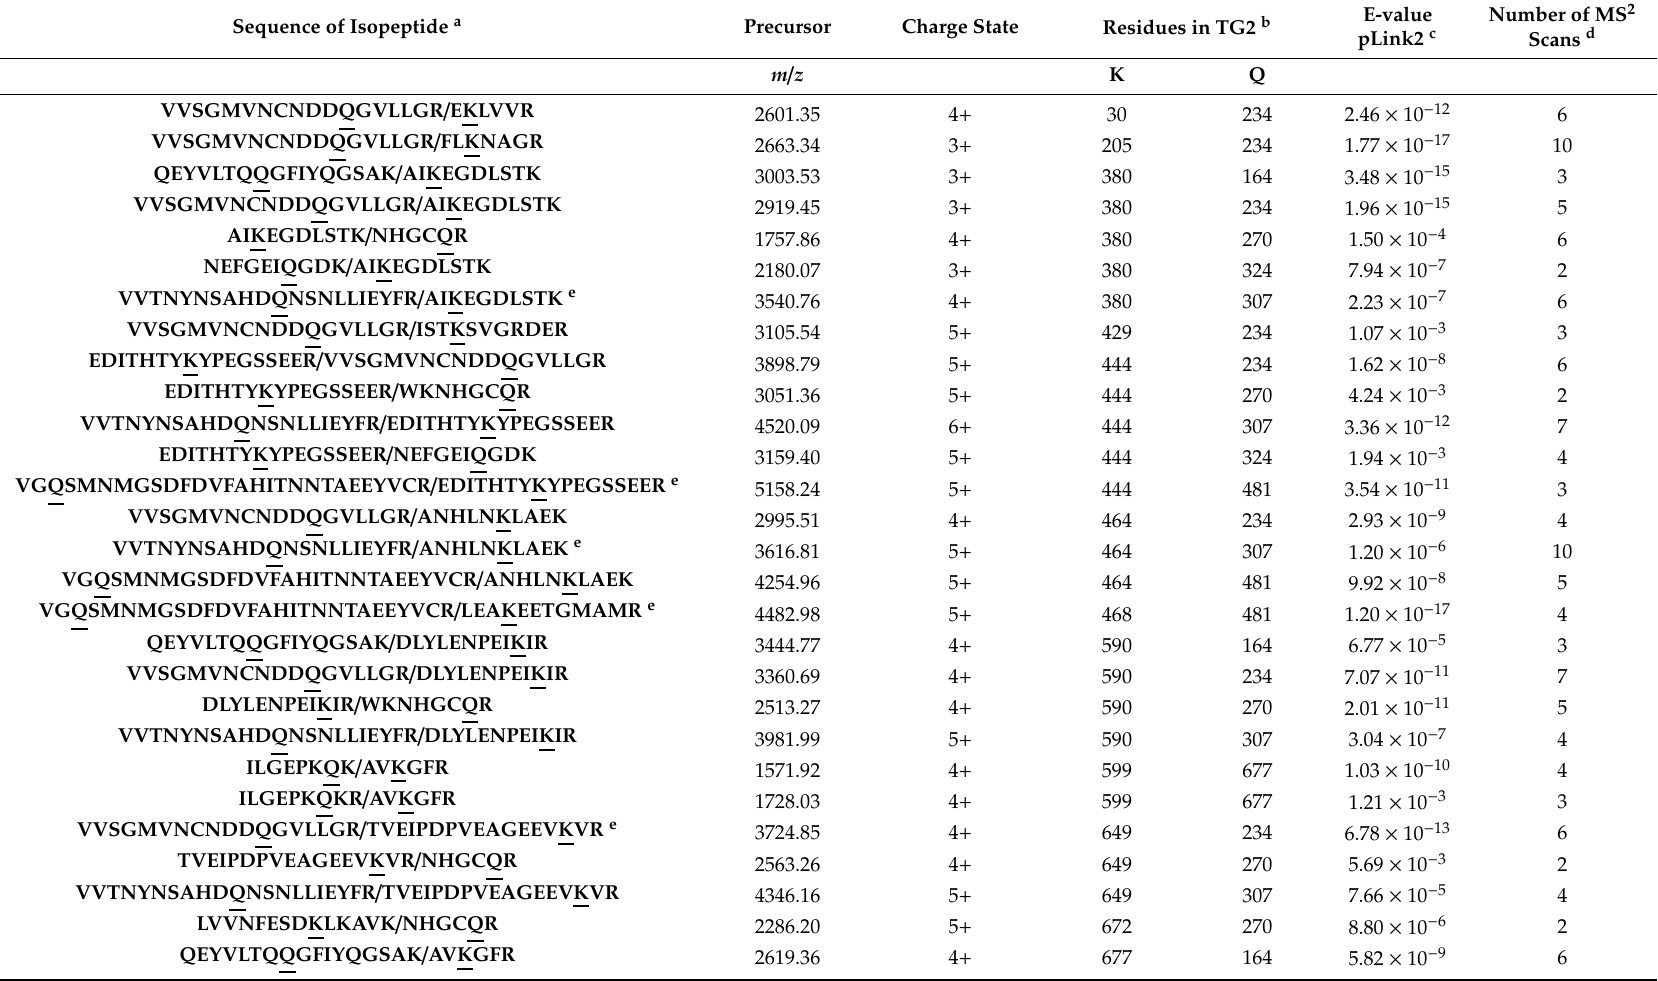
Table 2. Lysine residues and glutamine residues of TG2 involved in the formation of TG2 multimers. Sequence of Isopeptide